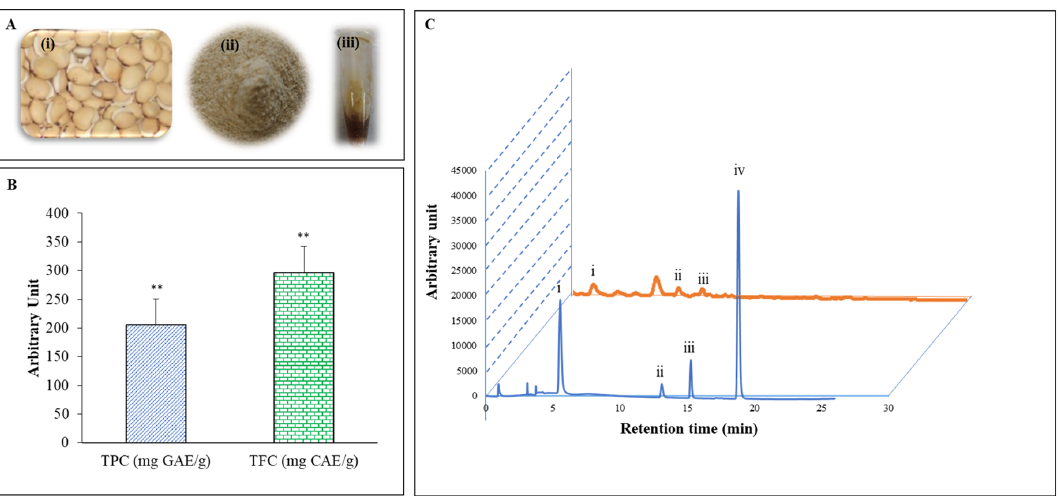
Figure 1. Photos of Lablab purpureus (LPE) ( A ) bean (i), powder (ii), and extract (iii). Total polyphenol content and flavonoids content ( B ) extracts of LPE (2 µL of samples). High-performance liquid chromatography (HPLC) (absorbance at 280 nm)—profile of phenolic standards and LPE ( C ). Peaks: gallic acid (i); catechin (ii); epicatechin (iii); and coumaric acid (iv). The injection volume was 20 µL, and the flow rate was maintained at 0.8 mL/min. All the tests were performed in triplicate.